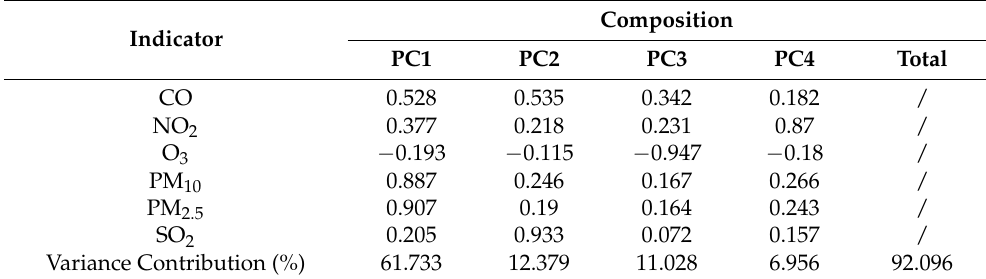
Table 3. Composition matrix of pollutant standard deviation after rotation. Indicator